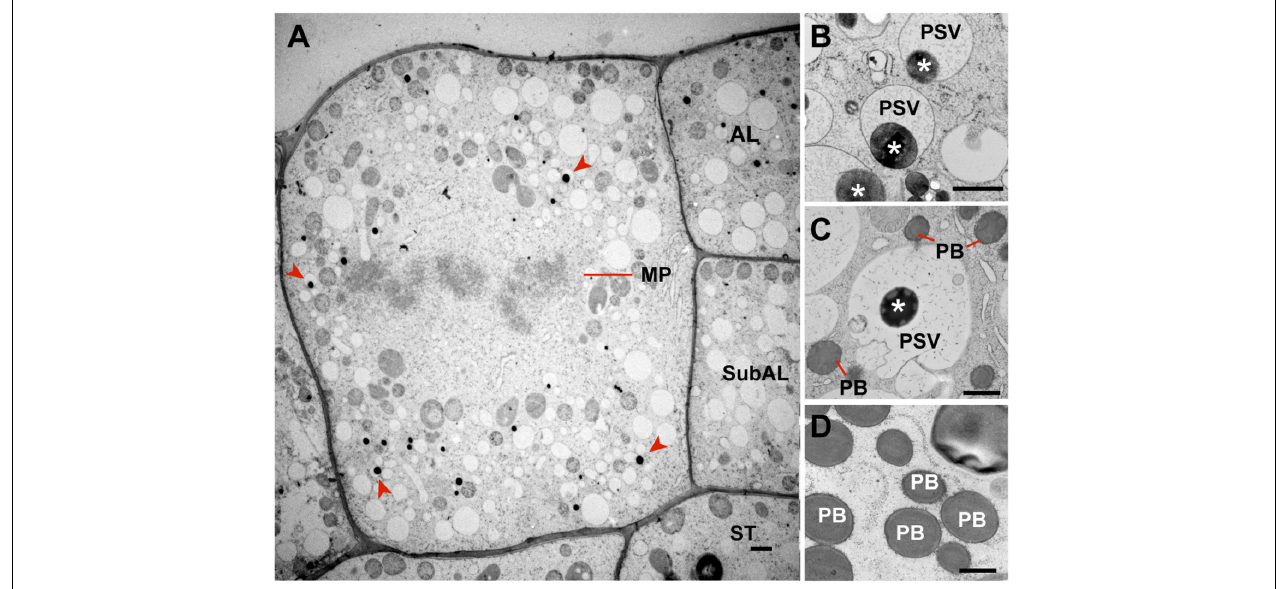
FIGURE 3 | Occurrence of microautophagy in endosperm cells at 17 DAP. (A) Aleurone cell undergoing mitosis. Periclinal cell divisions in the aleurone layer give rise to a new aleurone (AL) and a sub-aleurone (Sub-AL) cell. Note that this dividing aleurone cell contains vacuoles with storage protein inclusions (red arrowheads). (B) Protein storage vacuoles (PSVs) with storage protein inclusions (asterisks) in aleurone cells. (C) Sub-aleurone cells containing both PSVs with protein inclusions (asterisks) and ER protein bodies (PBs). (D) ER protein bodies (PB) in starchy endosperm cells. MP, metaphase plane. Scale bars = 1 µ